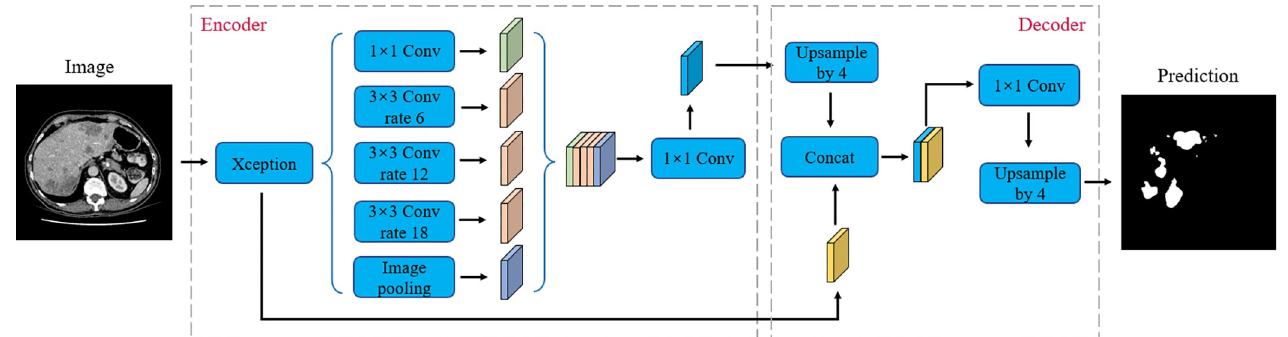
Fig 12. The detailed architecture of the